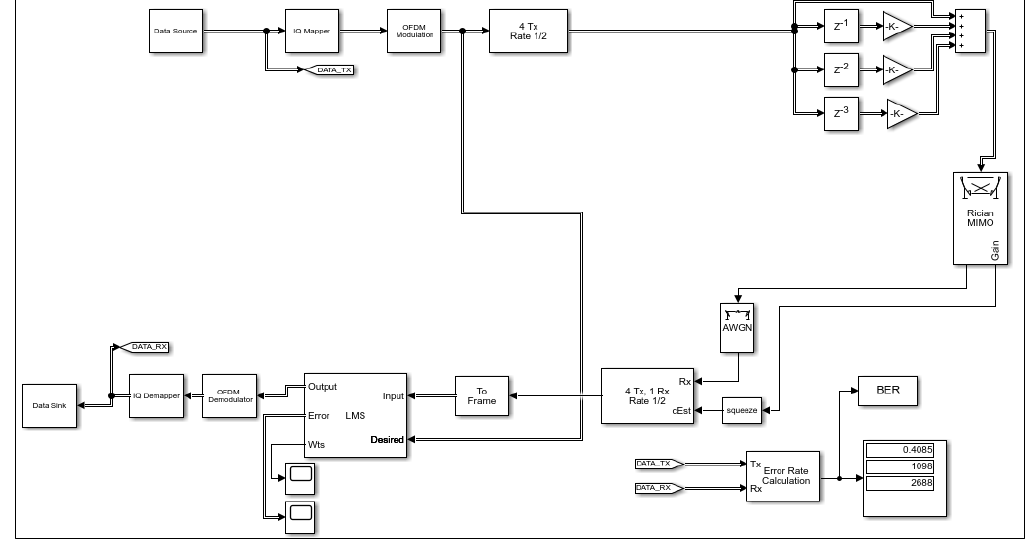
Figure 10. 4×1 LMS-MIMO-OFDM Model in Rician Channel.